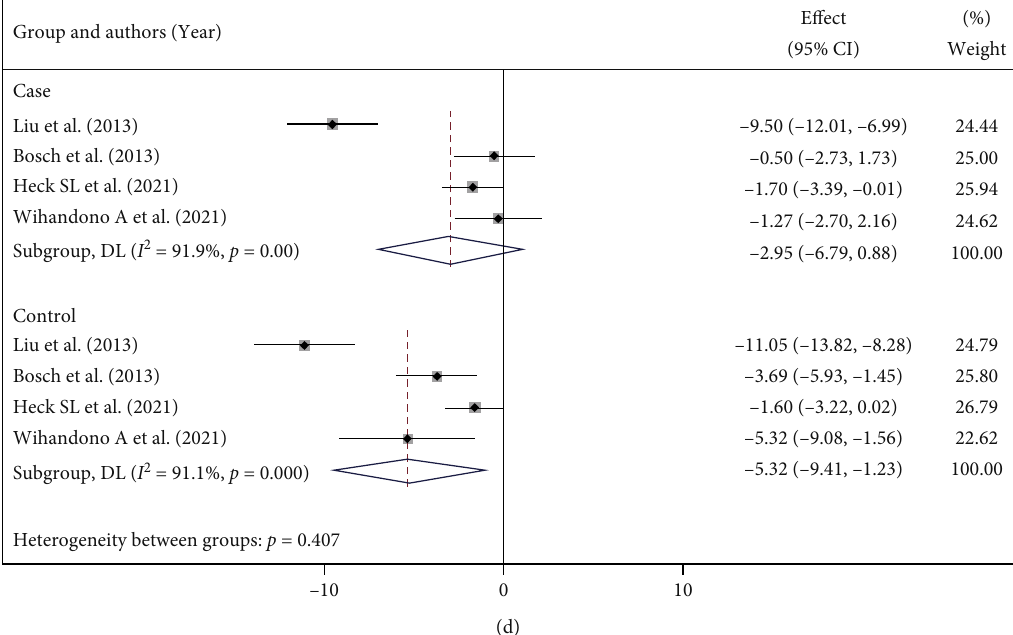
Figure 3: Forestplot of LVEF changes from the baseline of (a) Beta-blocker monotherapy and (b) Carvedilol monotherapy. (c) Other beta- blockers monotherapy. (d) Combination